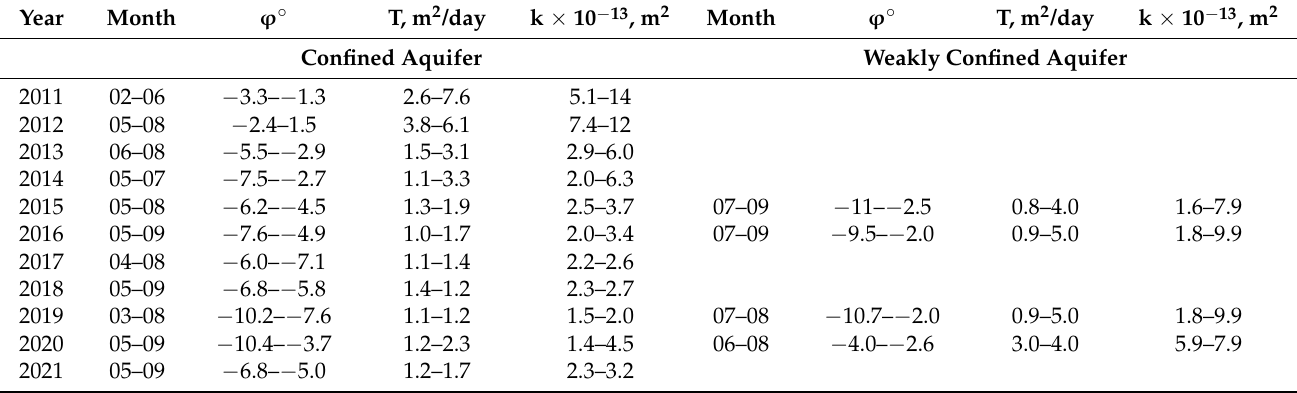
Figure 5b correspond to the numbers in the first column in Table 2. Table 1. Background characteristics of the fluid-saturated carbonate-terrigenous